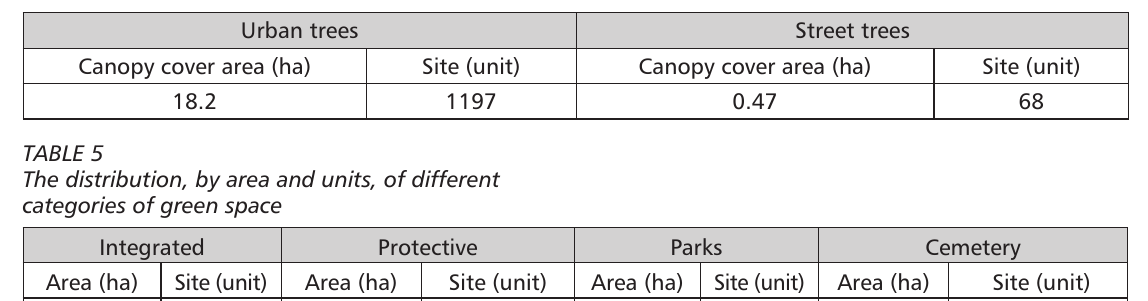
FIGURE 7 Green space and woody plant cover in Ariogala